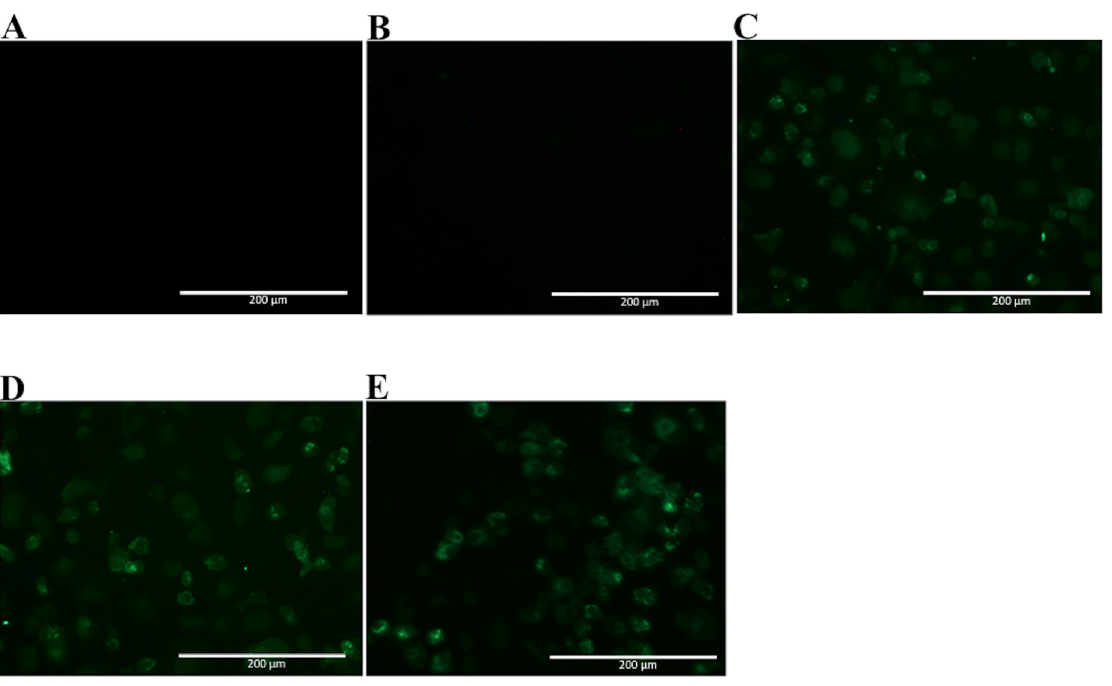
Figure 7. Reactivity of 4H2 mAb to Vero cells infected with DENV of different serotypes. Vero cells were infected with a MOI of 0.5, fixed, permeabilized and treated with mAb 4H2 48 h post infection. Then, cells were labeled with Alexa fluor ® conjugated goat-anti mouse IgG. The negative controls: ( A ) Mock infected cells treated with a pool of mAbs anti-NS1 and ( B ) DENV-infected cells labeled only with secondary antibody; Tested DENV serotypes: ( C ) DENV1; ( D ) DENV3 and ( E ) DENV4. Magnification of 200×.